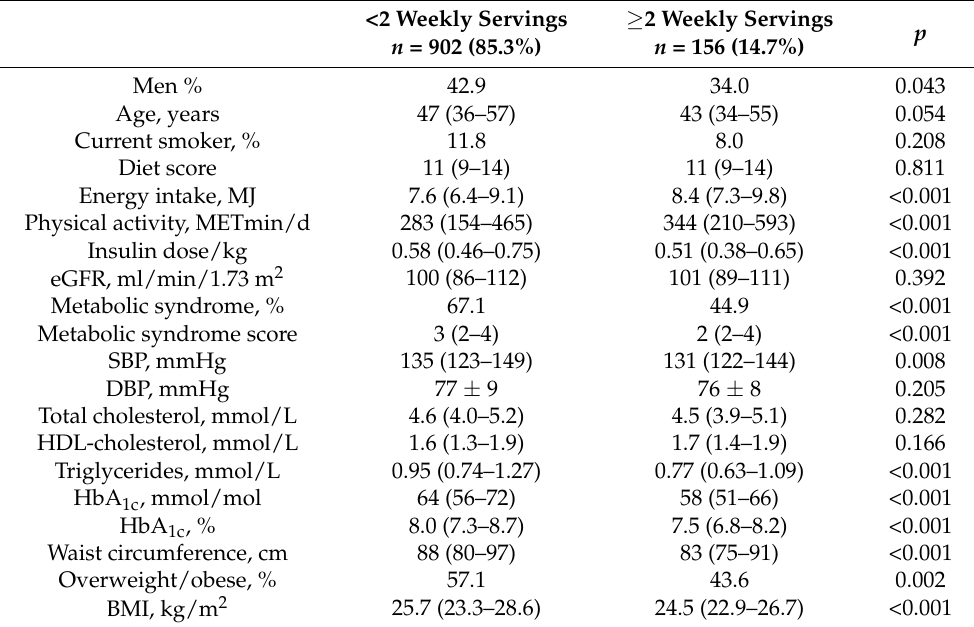
Table 1. Participant characteristics divided by the amount of nut consumption.